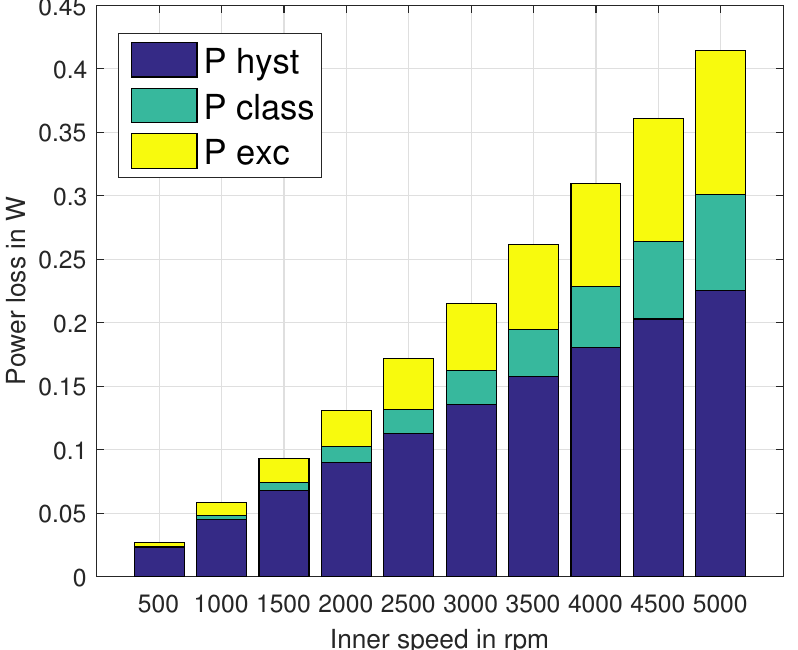
Figure 12. Inner iron yoke loss components. The losses are computed varying the rotors speed at the maximum torque